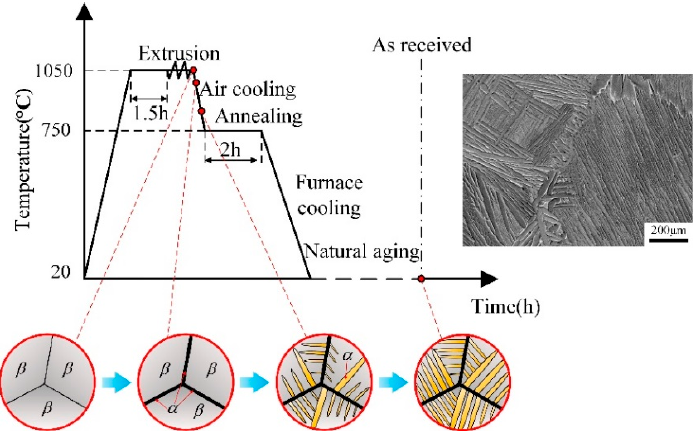
Figure 1. Schematic of the thermomechanical history of the as-received